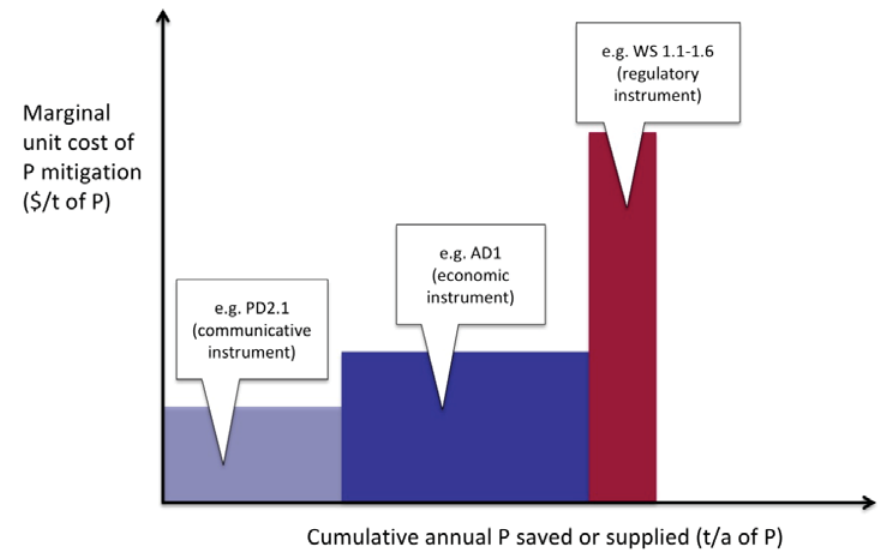
Figure 9. An indicative “supply curve of saved or supplied P” using some of the measures in Section 3. The ranking is illustrative